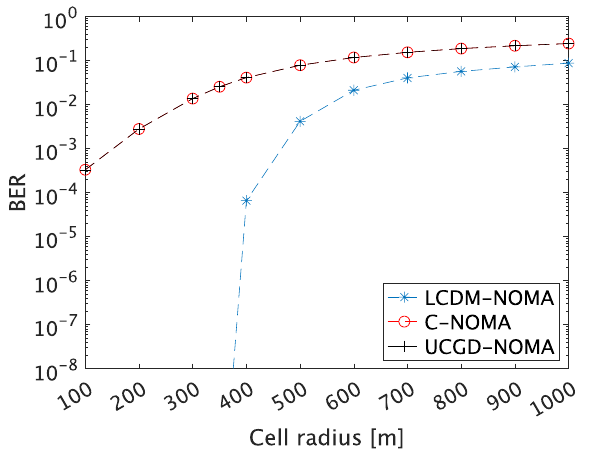
Figure 8. Comparison of the LCDM-NOMA with the C-NOMA and the UCGD-NOMA in BER. 5. Parameter Optimization for NOMA System with Laser Chaos Decision-Maker and Error Correcting